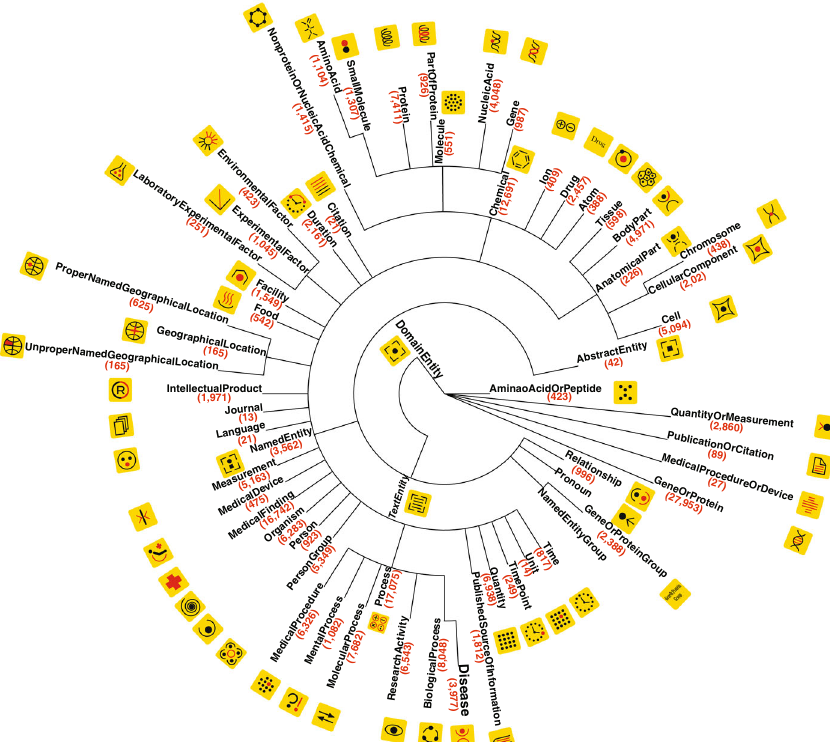
Fig. 1 Named Entity Recognition Ontology (NERO). The Ontology is shown here as a multifurcating tree, with taxonomy nodes corresponding to ontology classes. Class name and class mentions count in the corpus are shown in parentheses next to each named entity class. Each taxonomy class is provided with a unique pictogram (black and red shapes on yellow background) intended to simplify expert manual annotation of the corpora. In total, we annotated 35,865 sentences. These sentences encapsulated 190,679 named entities and 43,438 events connecting two or more entities. In addition to the almost two dozen, more sparsely-used branches (such as ExperimentalFactor and GeographicalLocation ) under the NamedEntity cluster, there are three heavily-represented branches in our corpus: AnatomicalPart , Chemical , and Process . Slightly more than half (51.6%) of all entities are from these three classes, with 26.6% of all entities originating from Process alone. We designed our ontology and its annotations to capture the named entities associated with research activities and facilities; these types of entities can be important for encoding methods used in scienti fi c experiments or patient treatment. The semantic classes ResearchActivity and MedicalProcedures turn out to be the ninth and the tenth most frequent, respectively. Other top concepts related to the research include Measurement , IntellectualProducts , PublishedSourceofInformation , Facility , and MentalProcess